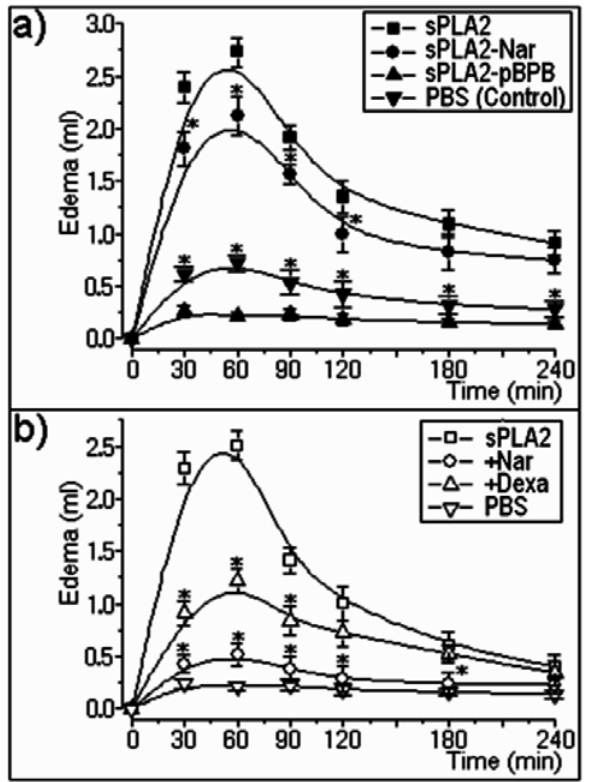
Figure 3. (a) Rat paw edema induced by sPLA2 and sPLA2-Nar showed dose-dependent edema with doses of 10 μ g/paw, whereas p-BPB treatment virtually abolished the edema induced by sPLA2. Observations were conducted at times of 30, 60, 90, 120, 180, and 240 minutes after injection. Results were expressed as the increase in paw volume (mL) calculated by subtracting the basal volume. Each point represents the mean ± S.E.M. of four rats and *P < 0.05. (b) Effect of previous injection of dexamethasone or naringin (3.0 mg/kg) before injection of native sPLA2. The results were expressed as microliters of plasma protein extravasation. Each point represents the mean of four animals, and each error bar indicates the S.E.M. *p < 0.05 compared with sPLA2